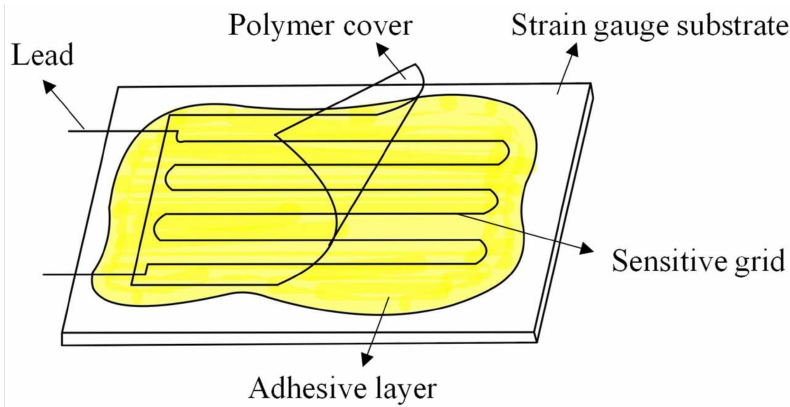
Figure 6. Structural diagram of the strain gauges used in the experimental test